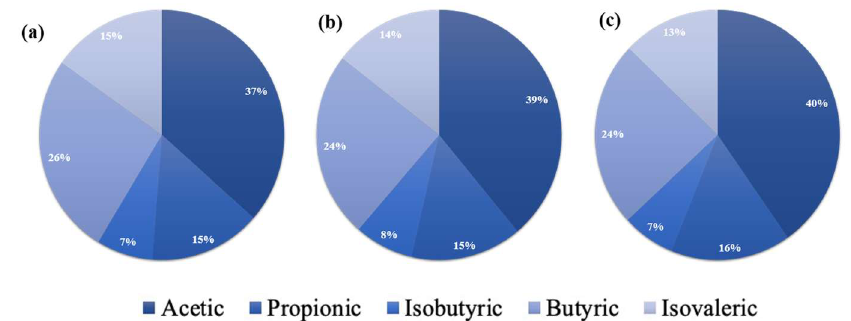
Figure 6. Composition in terms of the COD SOL percentage of the SCFAs obtained from the thermo- philic batch series T8 ( a ), T12 ( b ), and T8-P ( c ) as the average of all the initial pH.